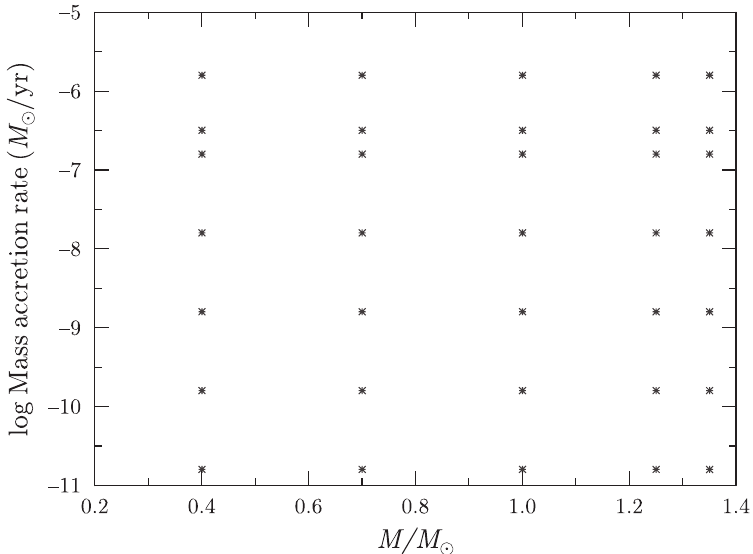
Fig. 1. WD mass and log ˙ M for each of the evolutionary sequences that we calculated. Since each point represents the two initial luminosities we used, there are 70 sequences shown here. Each of these exhibited a TNR. In no case did ‘steady burning’ occur.